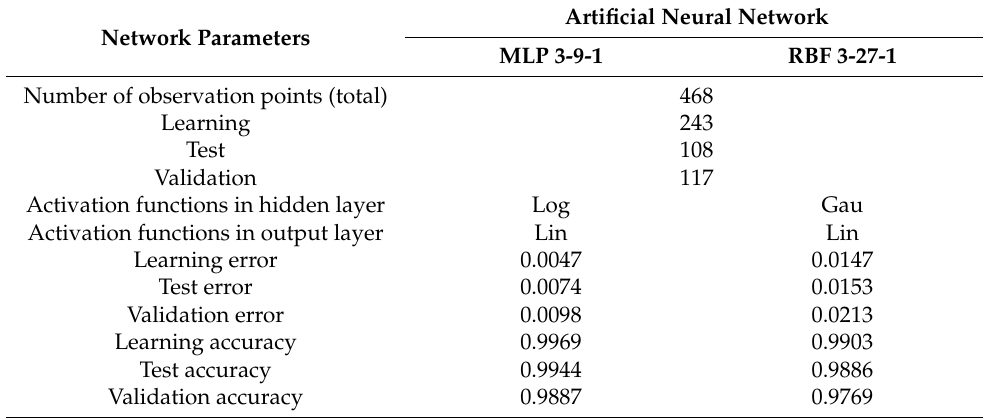
Table 1. Basic information on the structure and learning, test and validation error values of MLP and RBF neural networks selected as models of the neural network to predict phytosterol degradation in a stored bulk of